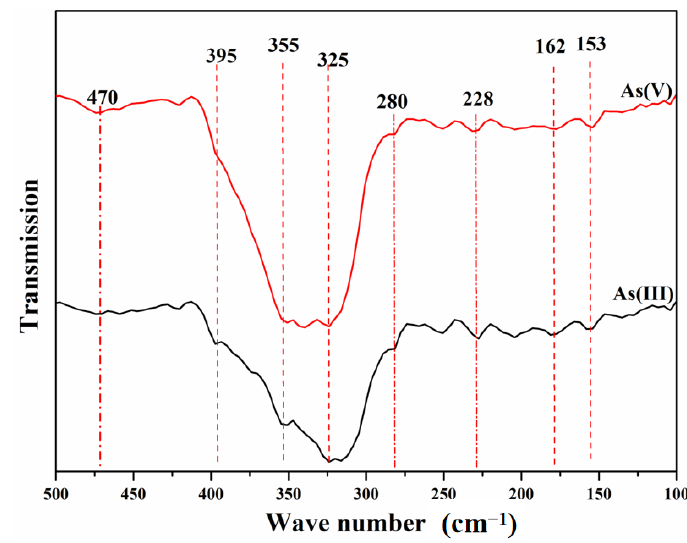
Figure 7. FTIR spectra of the precipitate-As(III) and the precipitate-As(V).